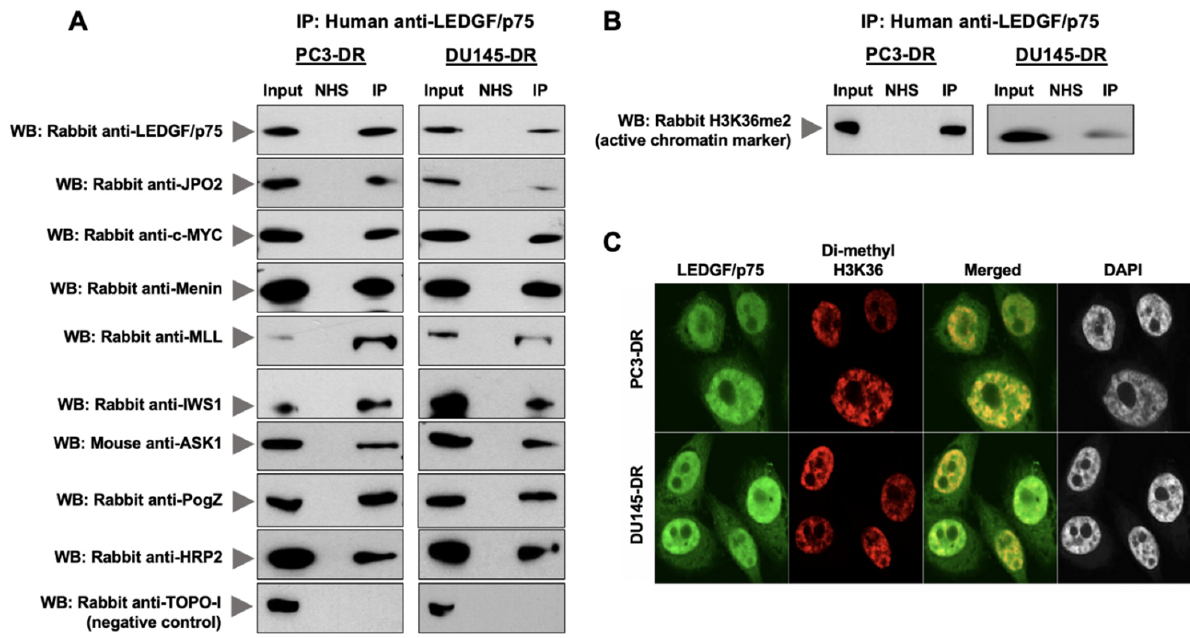
Figure 3. Human anti-LEDGF/p75 autoantibodies capture endogenous interactions with IBD-binding partners in DTX- resistant PCa cells. ( A ) Endogenous proteins from PC3-DR and DU145-DR cells were immunoprecipitated using highly specific and validated human sera containing autoantibodies to LEDGF/p75. Immunoprecipitated LEDGF/p75 and its endogenous IBD-interacting partners were detected by immunoblotting using specific rabbit or mouse antibodies. Proteins in cell lysates were also immunoprecipitated using an irrelevant normal human serum (NHS) as negative control. Input represents 1% of the protein concentration of the immunoprecipitated cell lysate. TOPO-1 was included as a negative control since there is no evidence of its interaction with LEDGF/p75. ( B ) Di-methyl histone H3K36 (H3K36me2), a marker for active chromatin, was immunoprecipitated with anti-LEDGF/p75 autoantibodies. ( C ) Rabbit antibody to H3K36me2 was co-incubated with human anti-LEDGF/p75 autoantibodies in DTX-resistant cells and detected with rhodamine-labeled secondary antibody (red). Merged images show the yellow-orange staining typical of colocalization. DAPI was used for nuclear staining. Images were acquired by confocal microscopy. Scale bar, 10 µ m, applies to all confocal